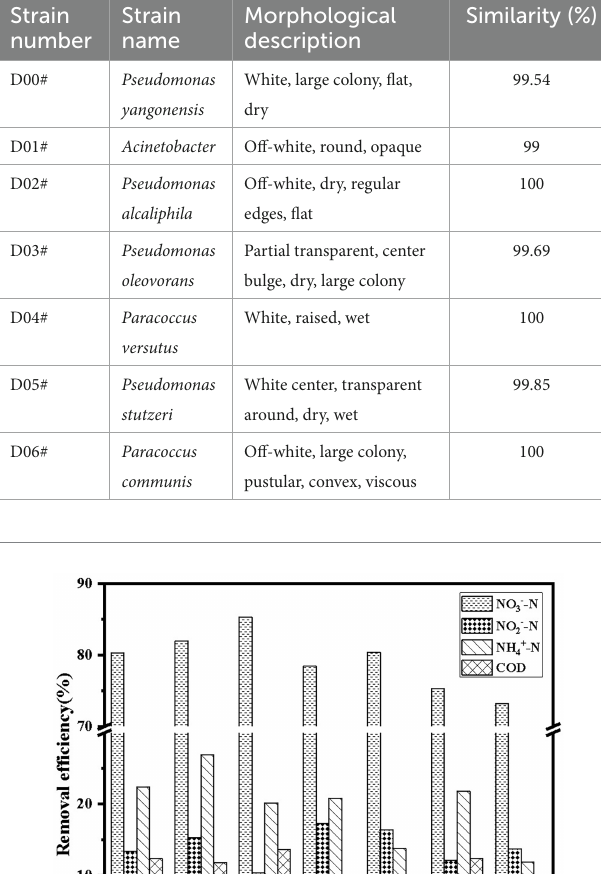
TABLE 2 Screening results of aerobic denitrification functional bacteria.